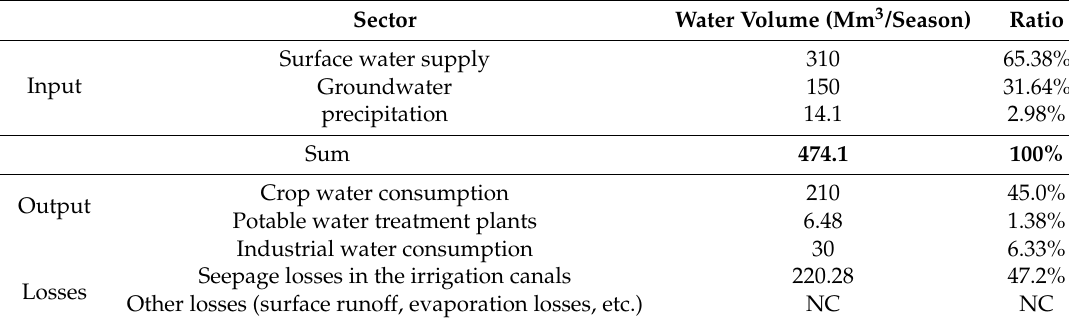
Table 4. Water balance in the study area during the winter season (from November 2015 to May 2016).